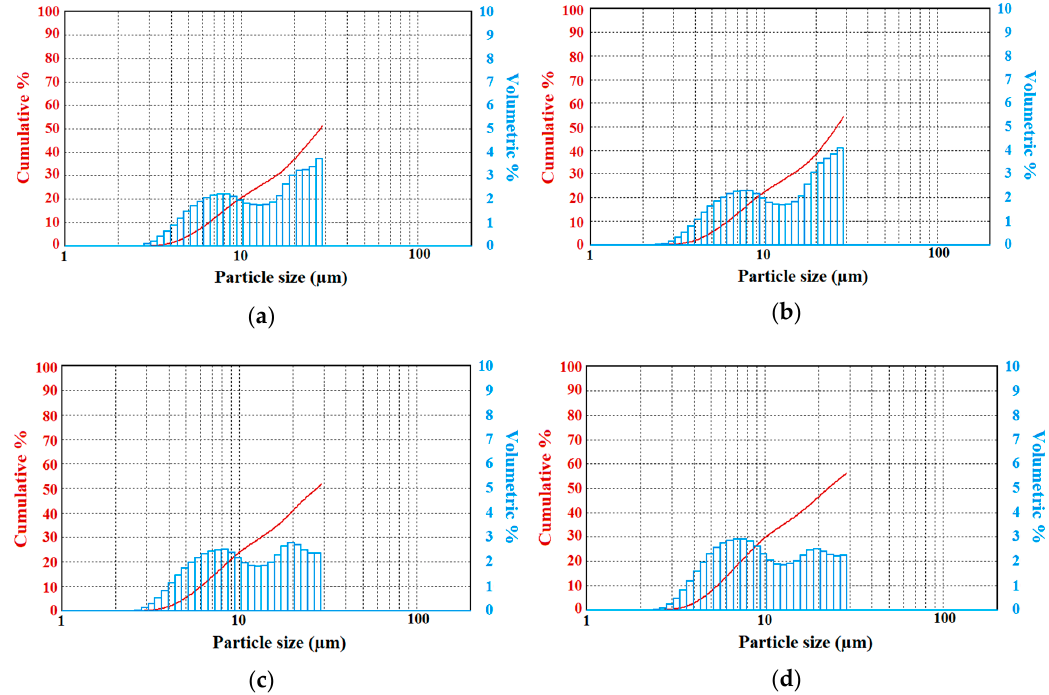
Figure 4. The % of solution contribution to fog spectral volume (right y -axis) and cumulative particle volume concentration (left y -axis) versus droplet diameter ( x -axis) are shown similarly in ( a ), ( b ), ( c ), and ( d ). Averaged fog droplet spectra below 30 µ m containing 2.5%, 5%, 7.5%, and 10% of the amounts of potassium dihydrogen phosphate (PDP) are shown in ( a ), ( b ), ( c ), and ( d ),